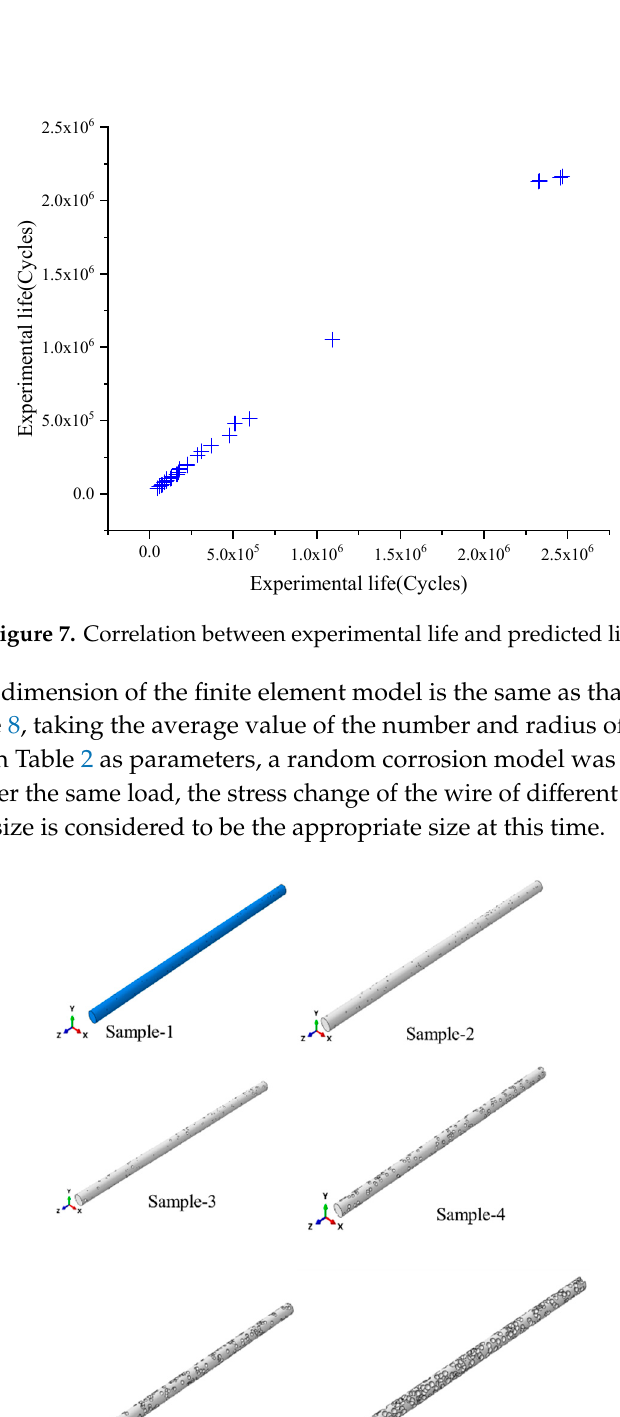
Figure 8. Finite model in Abaqus.